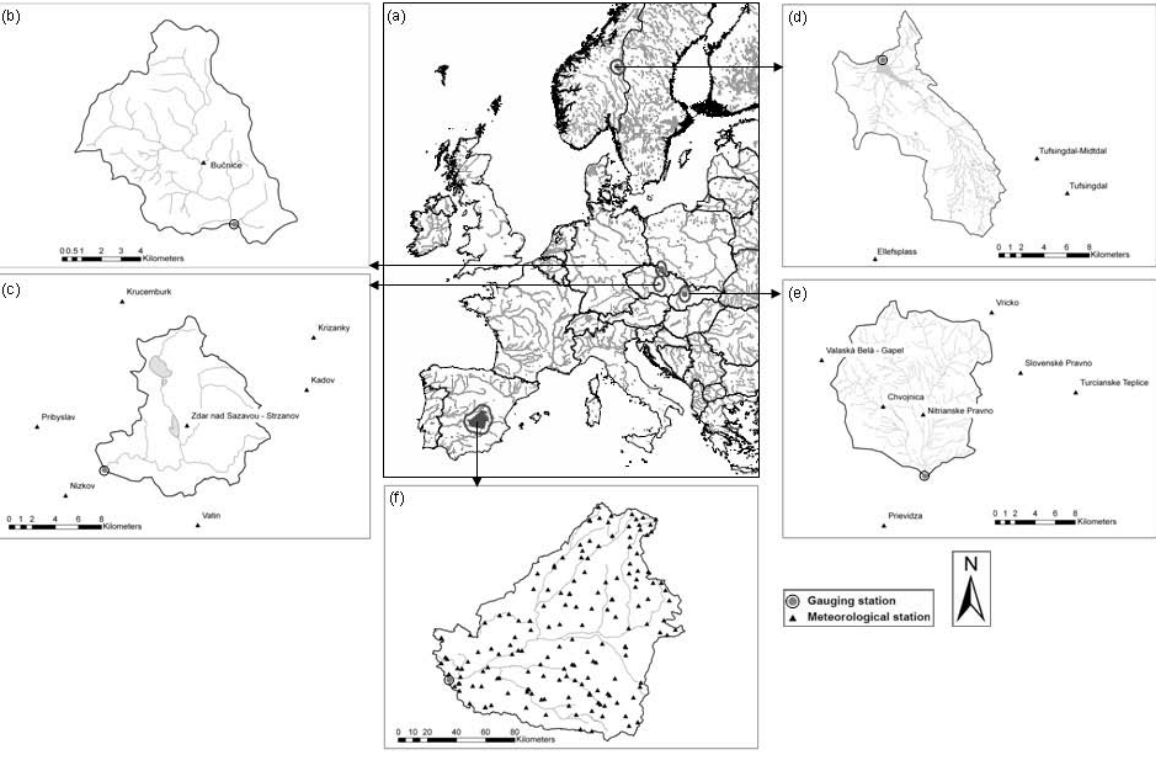
Fig. 2. (a) Location of the selected catchments in Europe, including gauging station and meteorological stations; (b) Upper-Metuje catchment; (c) Upper-S´azava catchment; (d) Narsjø catchment; (e) Nedoˇzery catchment; and (f) Upper-Guadiana